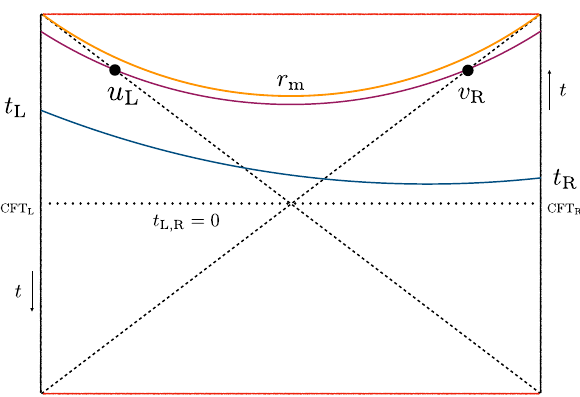
Fig. 16 Various bulk slices of the eternal AdS-BH geometry. These slices are anchored at t R on the right boundary and on t L on the left boundary. For E (cid:21) 1, the turning point is located near r H and therefore the corresponding slice is close to the t L , R = 0 one, as shown by the dotted black horizontal line. For E (cid:16) 1, the turning point